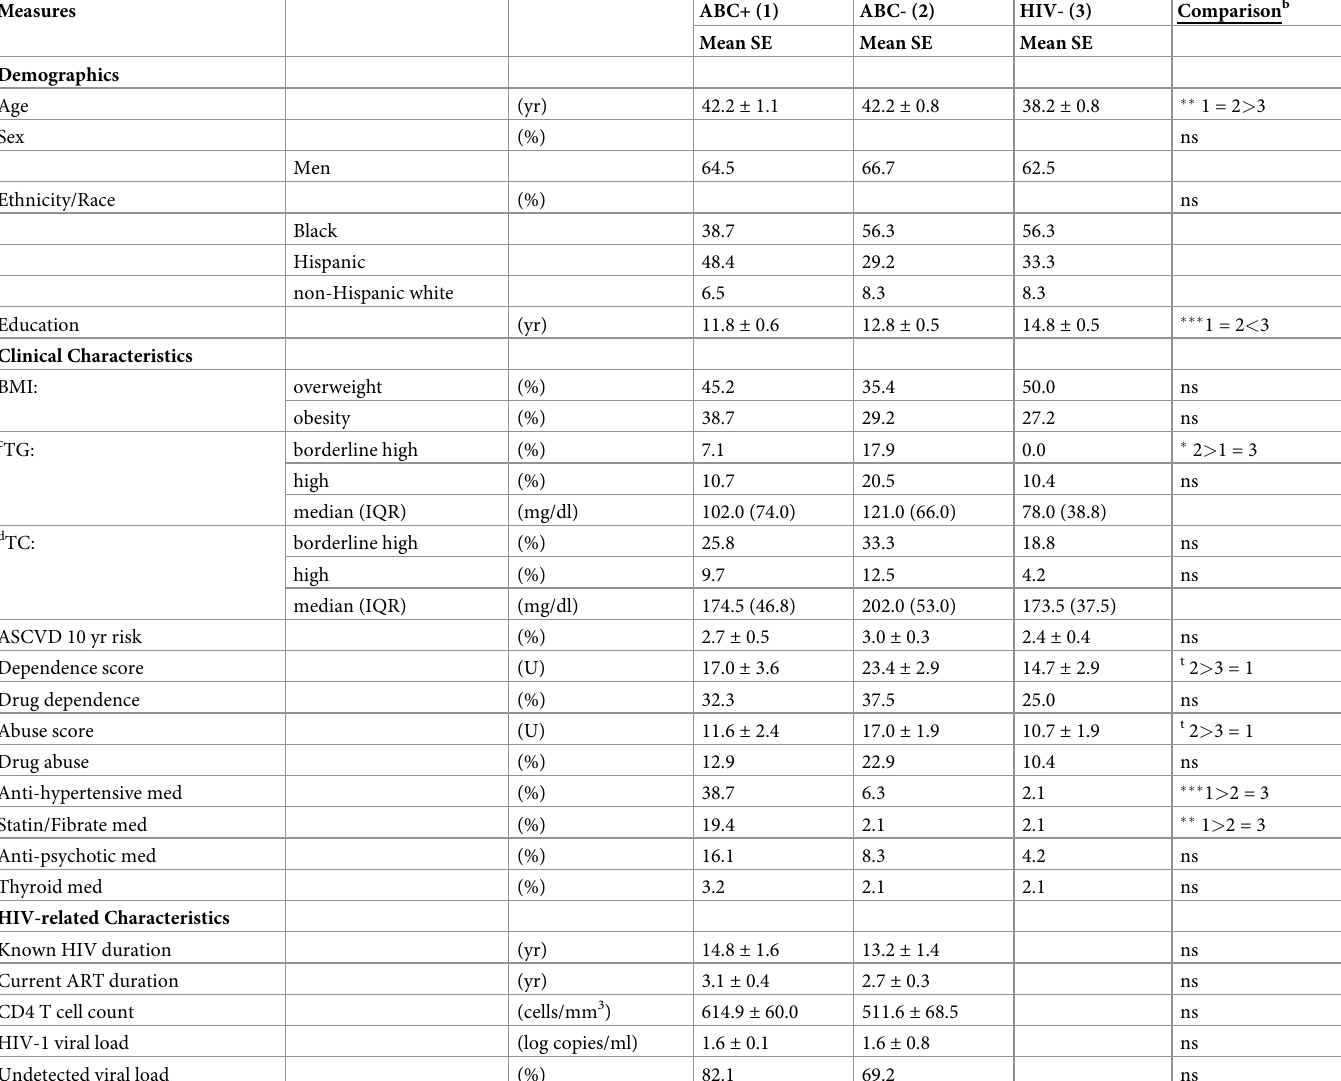
Table 1. Sociodemographic, clinical, and HIV-Related characteristics of participants by study group a